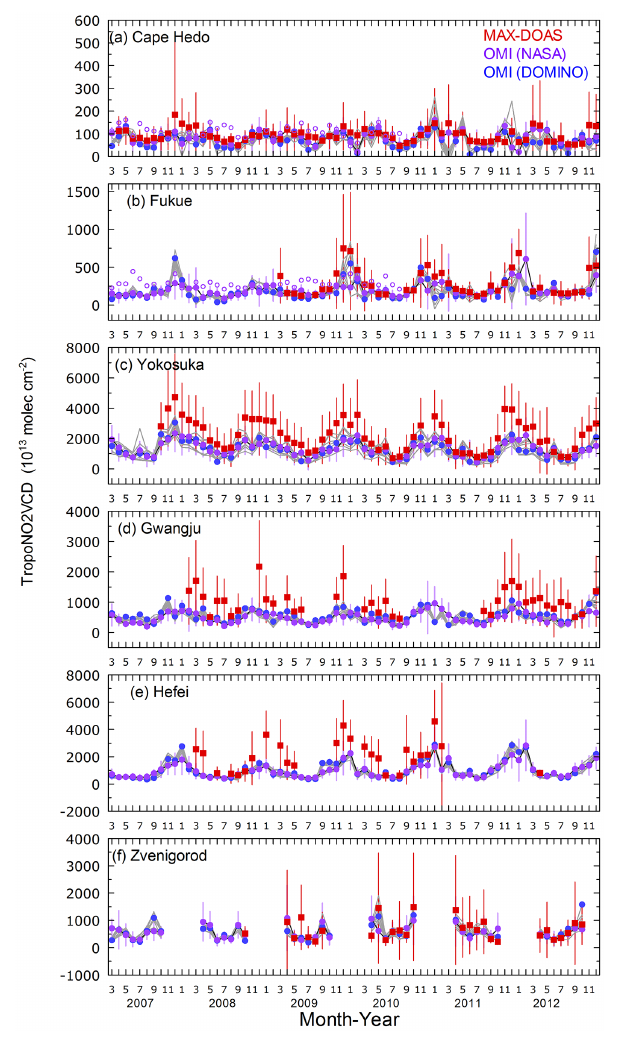
Figure 7. Time series of monthly averages of MAX-DOAS (red) and satellite observations of TropoNO2VCD. The satellite observa- tions are derived using NASA (ver. 2.1, purple) and DOMINO (ver. 2.0, blue) algorithms. Open purple circles in (a) and (b) represent data from older products (NASA ver. 1). Error bars of MAX-DOAS represent 1 σ ranges of included data. Error bars of OMI with the NASA ver. 2.1 algorithm were calculated from 1 σ ranges of daily data included in the month. Gray lines represent OMI data using the DOMINO ver. 2.0 algorithm at the eight grids (0.125 ◦ × 0.125 ◦ ) adjacent to the grid nearest the site (blue